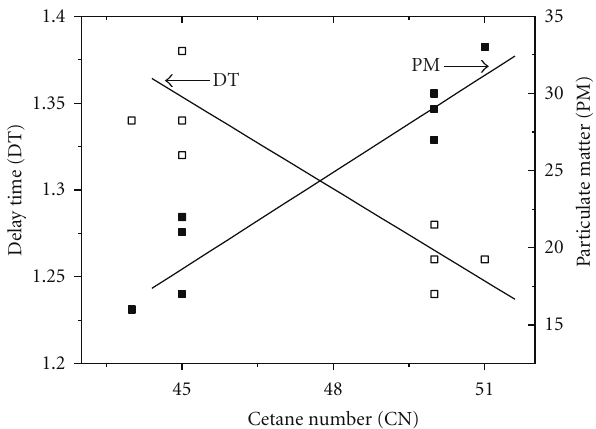
Figure 4: Ignition delay time and PM emissions as a function of CN.